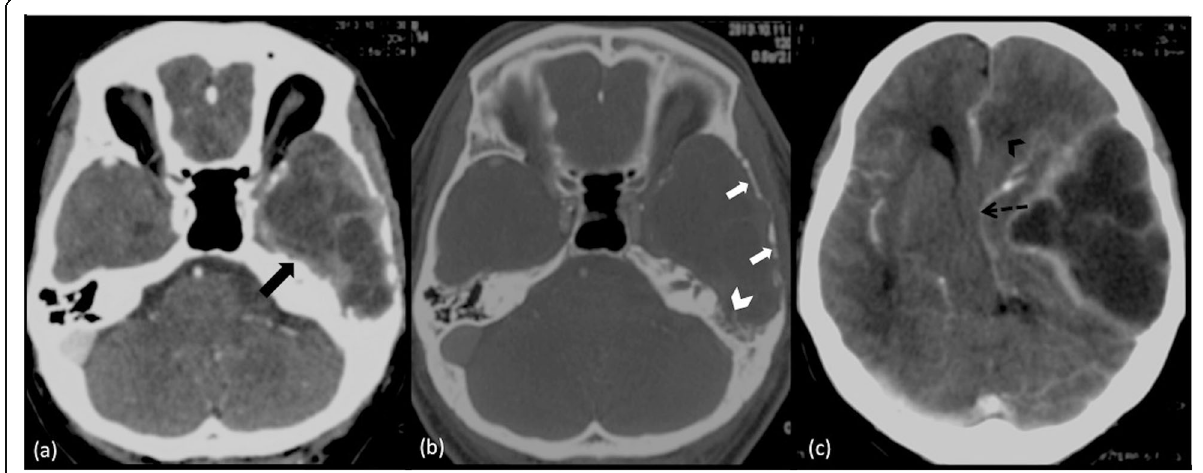
Fig. 1 Contrasted CT of the brain in the axial plane. a An extra-axial, peripherally enhancing multiseptated lesion is seen at the left temporal fossa (black arrow). b The lesion caused thinning of the temporal bone (white arrow) with destruction of the petrous temporal bone (arrowhead). c The lesion extended to the left parietal area and caused compression of the left lateral ventricle (black arrowhead) as well as a midline shift to the right (broken